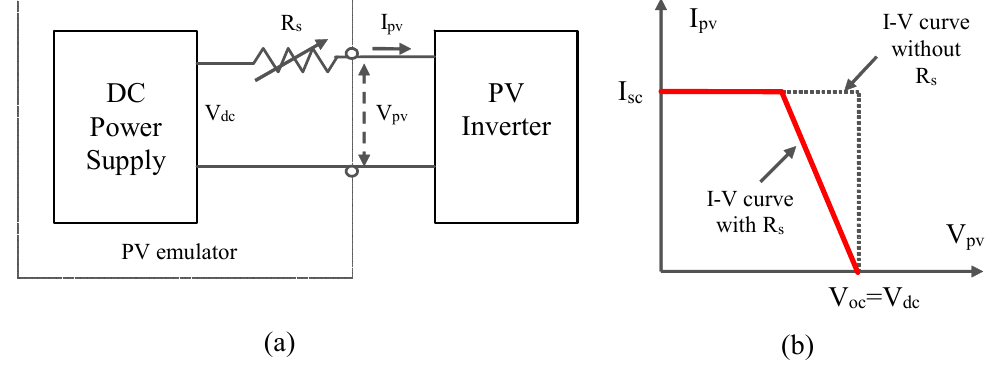
Figure 3. PV simulator based on DC power supply and a series resistor ( a ) circuit connection; ( b ) I-V curves [8].